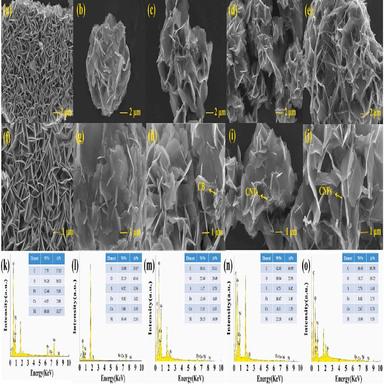
SEM images and EDS spectra of CoNiFe–LDH (a, f, k); CoNiFe(SDS)–LDH (b, g, l); CB/CoNiFe(SDS)–LDH (c, h, m); CNTs/CoNiFe(SDS)–LDH (d, i, n); CNFs/ CoNiFe(SDS)–LDH (e, j, o).